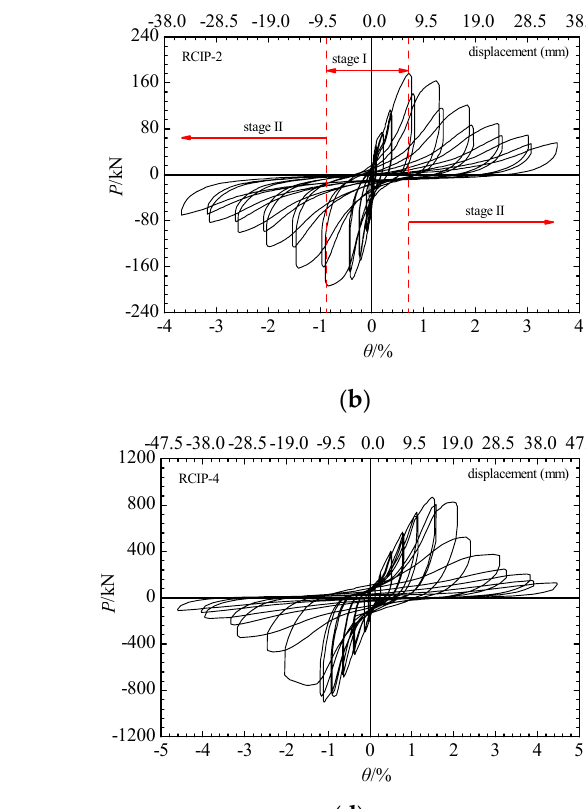
Table 3. Characteristic lateral loading responses.